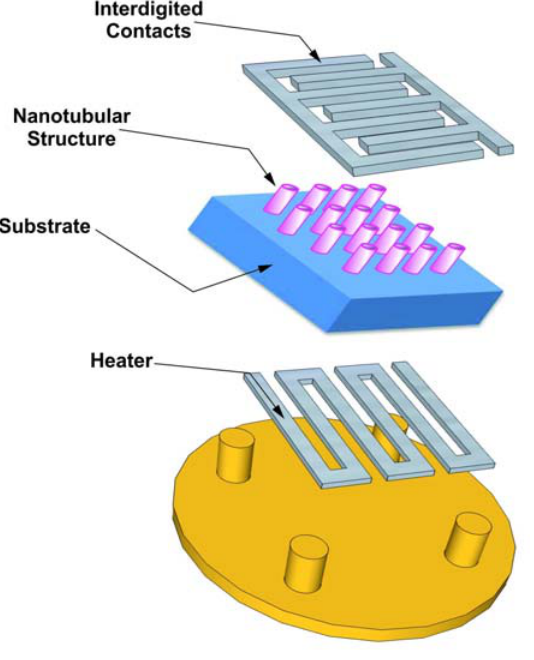
Figure 14. Design of a conductometric